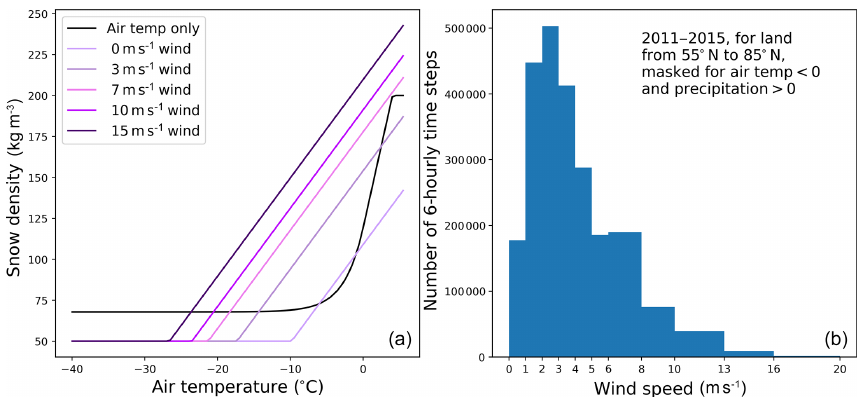
Figure 6. (a) Snow density as a function of air temperature for the original CLASS-CTEM formulation (Eq. A19) and for Exp. Fresh snow density , which includes consideration of wind speed (Eq. A20; purple lines indicate different wind speeds). (b) Histogram of wind speeds for the period 2011 to 2015 from the CRUNCEP meteorological